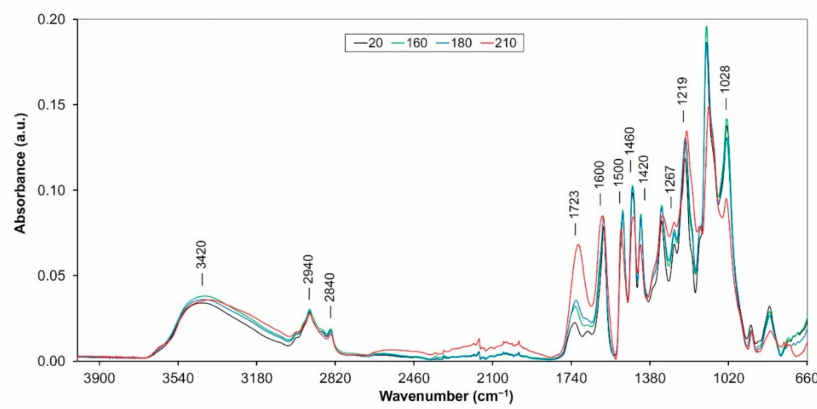
Figure 1. FTIR spectra of the thermally treated lignin from oak